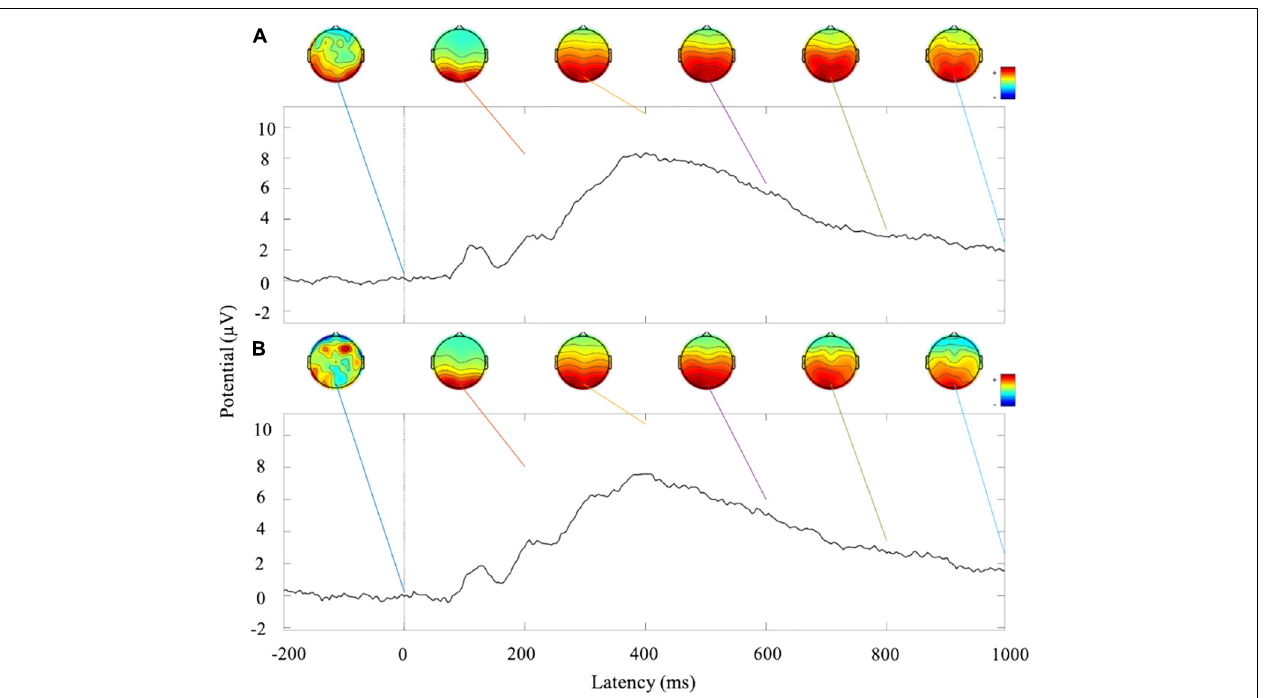
FIGURE 4 | Analysis of ERP amplitude and topographic map of cue reactivity task. (A) ERP waveform and topographic maps of the first visit of cue reactivity task phase. (B) ERP waveform and topographic maps of the second visit of cue reactivity task phase.